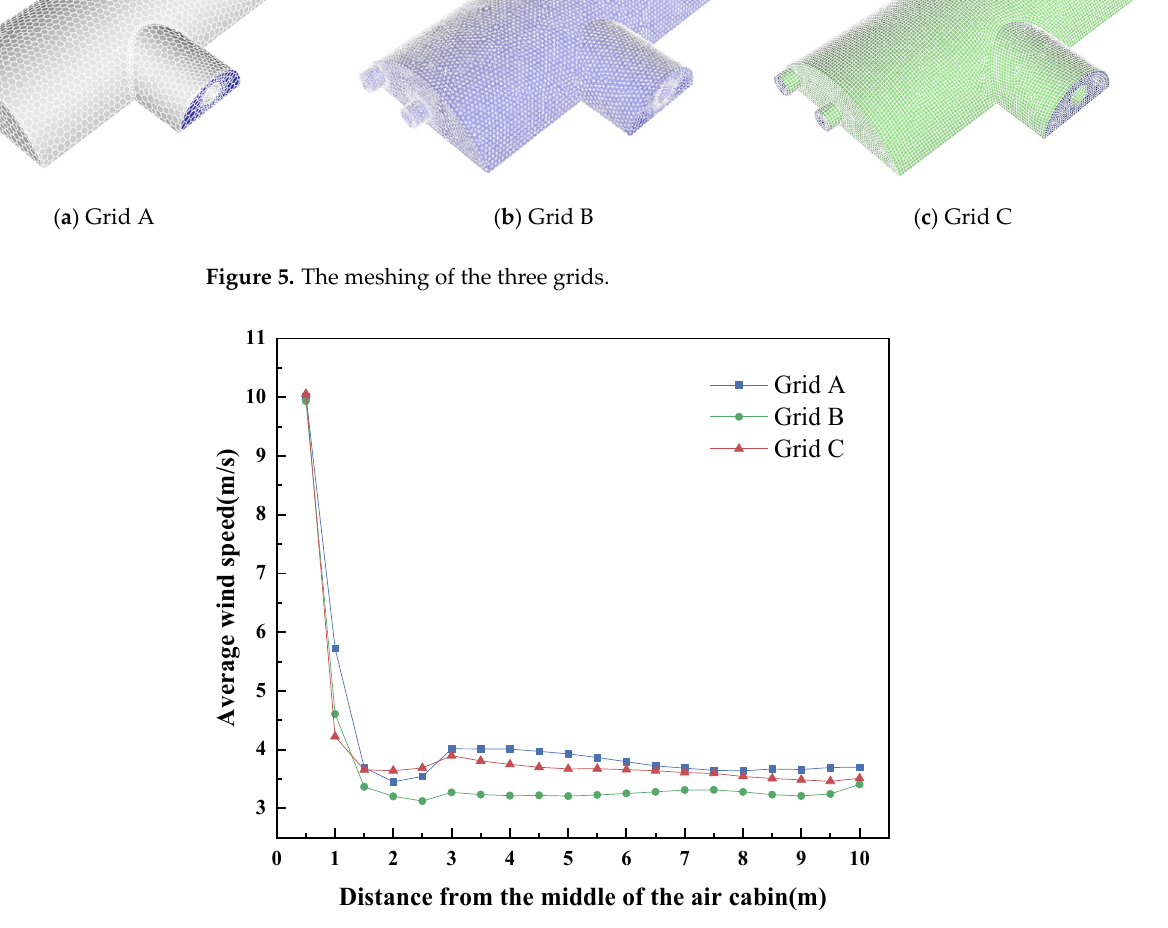
Figure 6. Comparison of the average air velocity of the three grids.